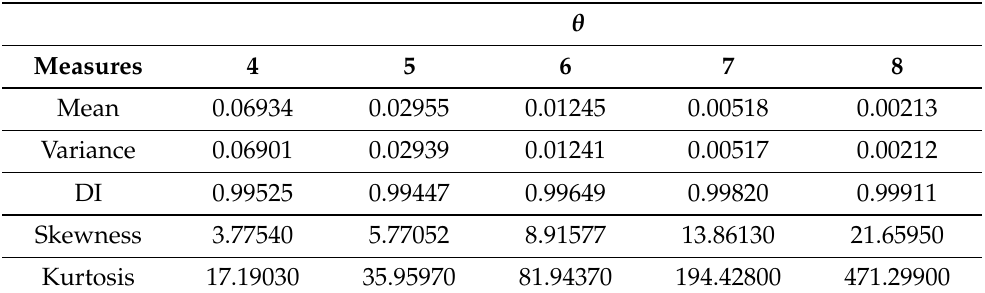
Table 1. Values for some moment measures for the DPsL distribution for β = 1.5 and different values of θ .